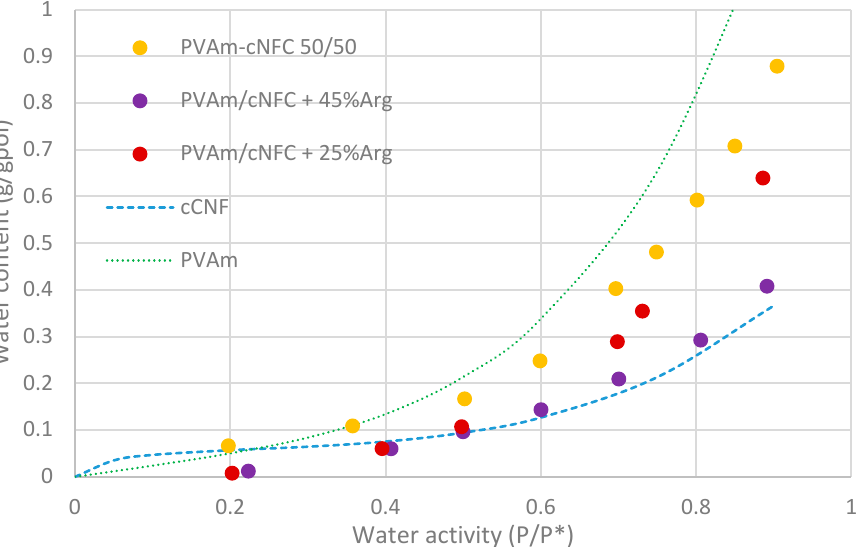
Figure 5. Sorption isotherm of the different systems investigated in the present work. Literature data related to the purified PVAm [25] and investigated nanocellulose [19] are also reported for completeness.